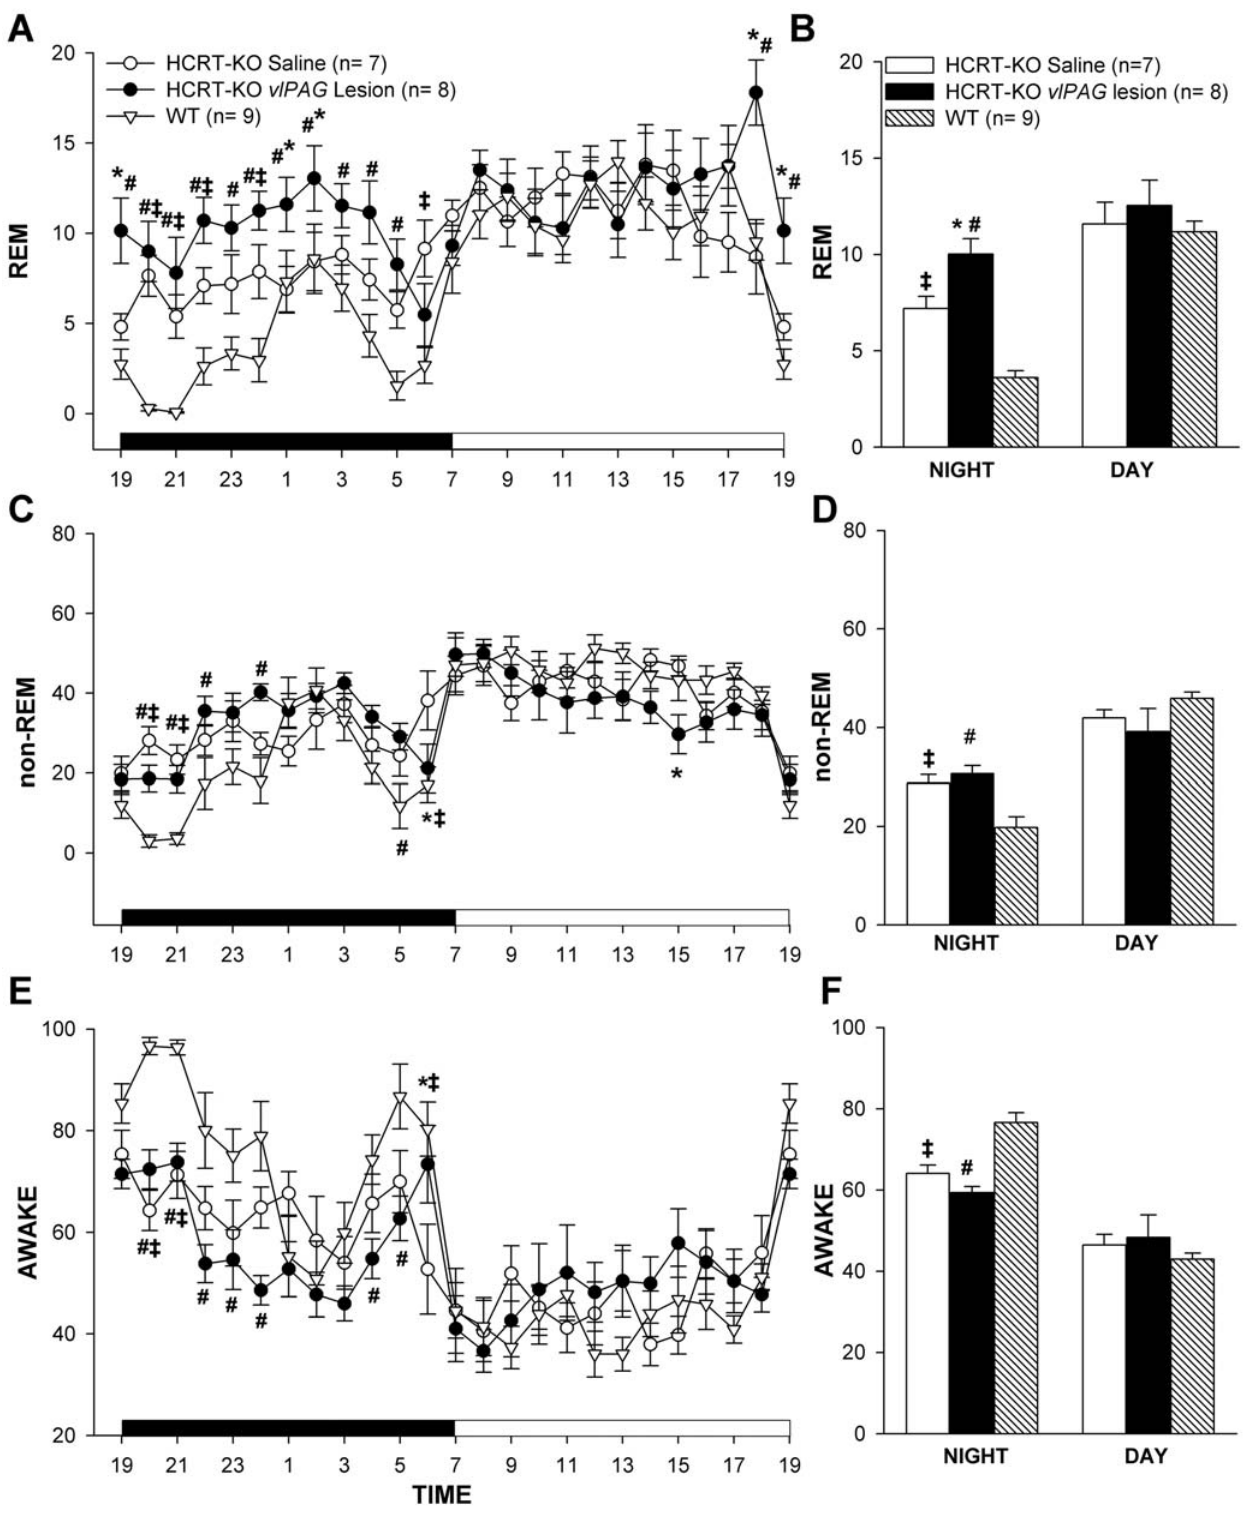
Figure 3. Mean ( 6 SEM) percent REM, non-REM and wake states in HCRT -ko mice with vl PAG lesions compared to saline injected HCRT -ko and wildtype mice. The line graphs (A, C, E) summarize the hourly average of the sleep-wake states over the 24 h period. The dark bar (A, C, E) represents the lights-off period and the white bar represents the lights-on period of 12:12 h of the L:D cycle. The bar graphs (B, D, F) represents the average ( 6 SEM) REM, non-REM and wake levels during the 12 h day and night periods. *=P , 0.01 for HCRT -ko saline vs. HCRT -ko vlPAG lesion, # - represents P , 0.01 for WT vs. HCRT -ko vlPAG lesion and { - represents P , 0.01 WT vs. HCRT -ko saline.